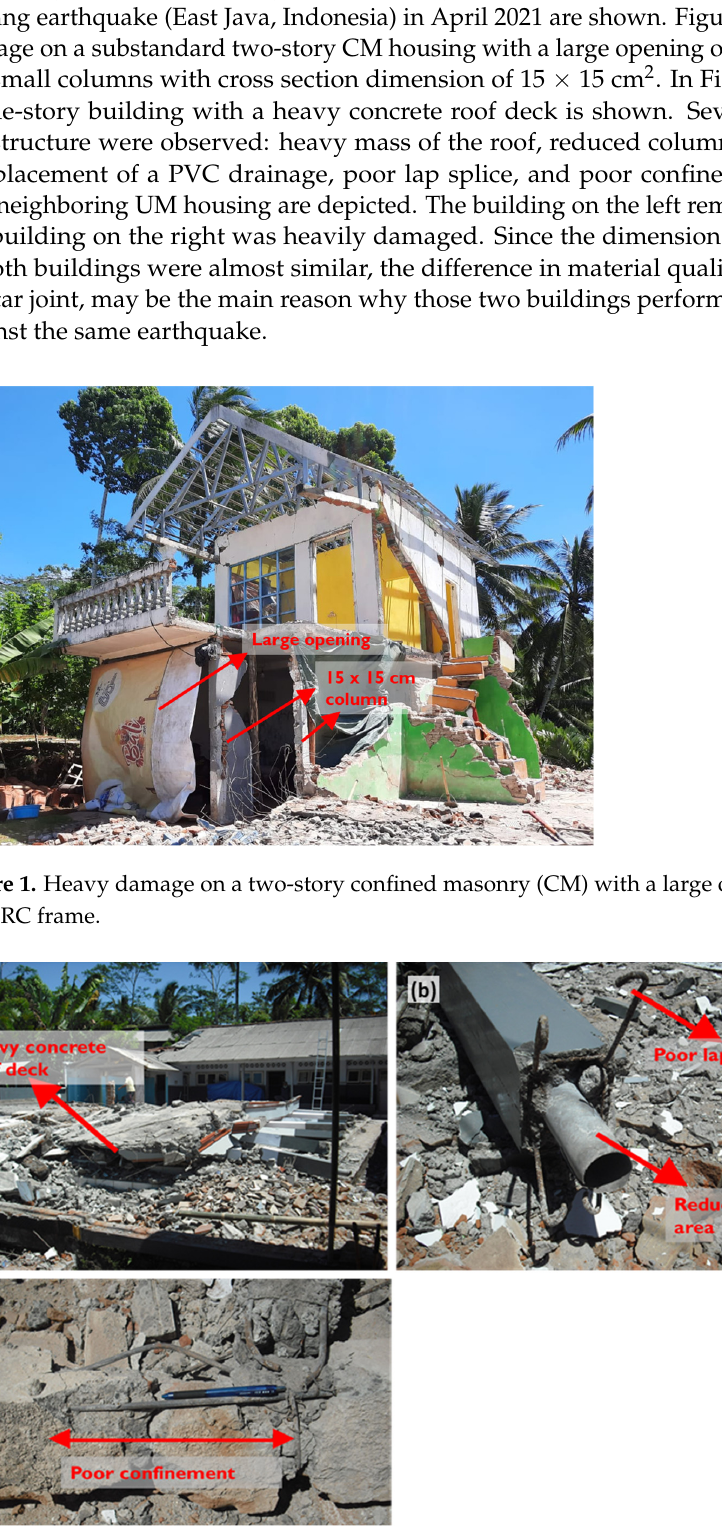
Figure 2. ( a ) Collapse of a single-story CM building with ( b ) poor column design and lap splice, and ( c ) low confinement . ( c ) low